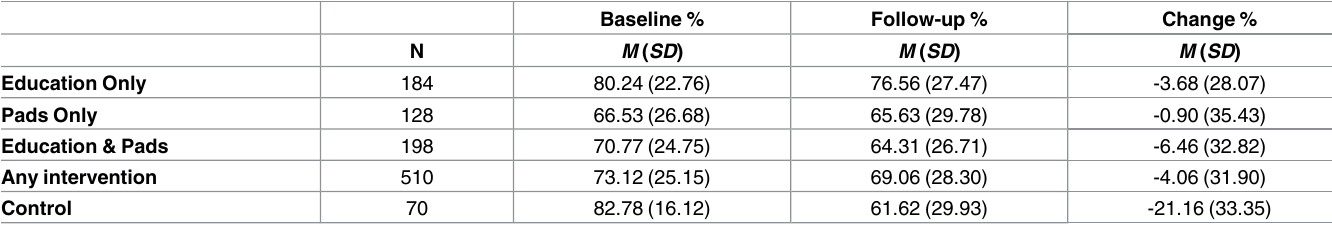
Table 3. Mean percentage attendance at baseline, follow-up and change scores across conditions (n =